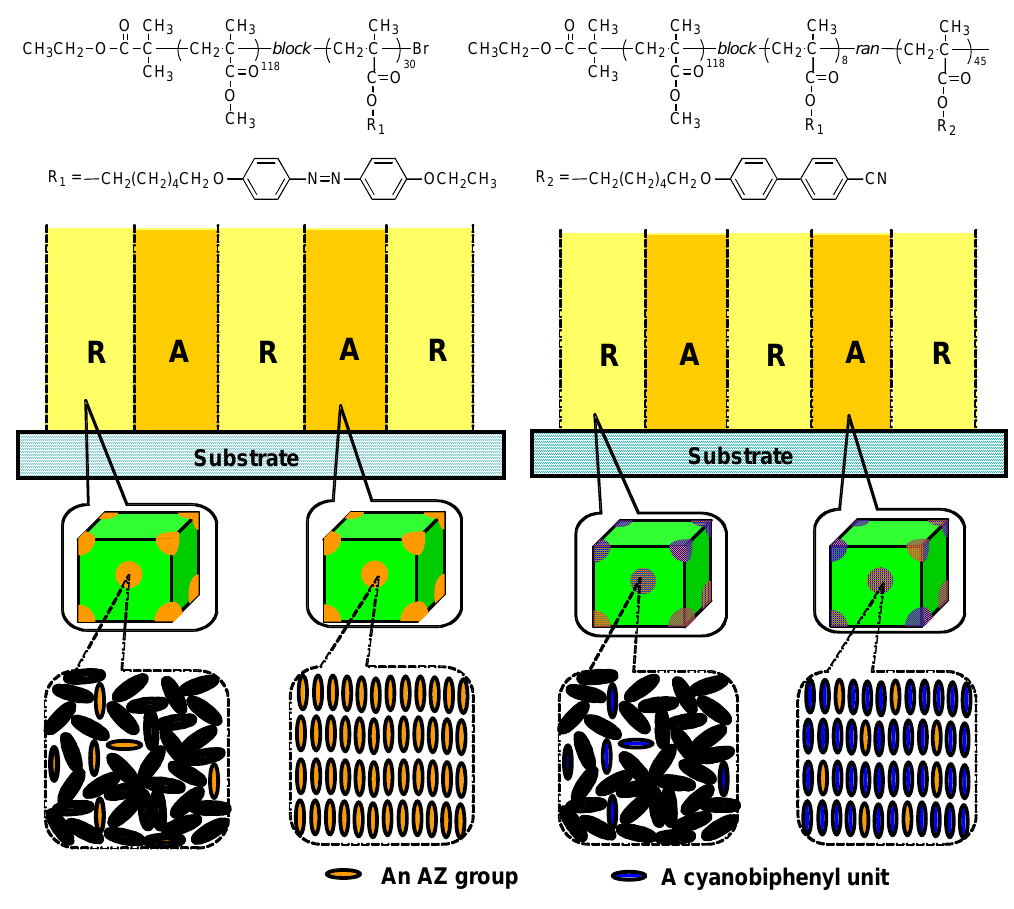
Figure 18. Enhancement of surface-index modulation in PRBCs with photoresponsive groups in the minority phase. (A, aligned, R,